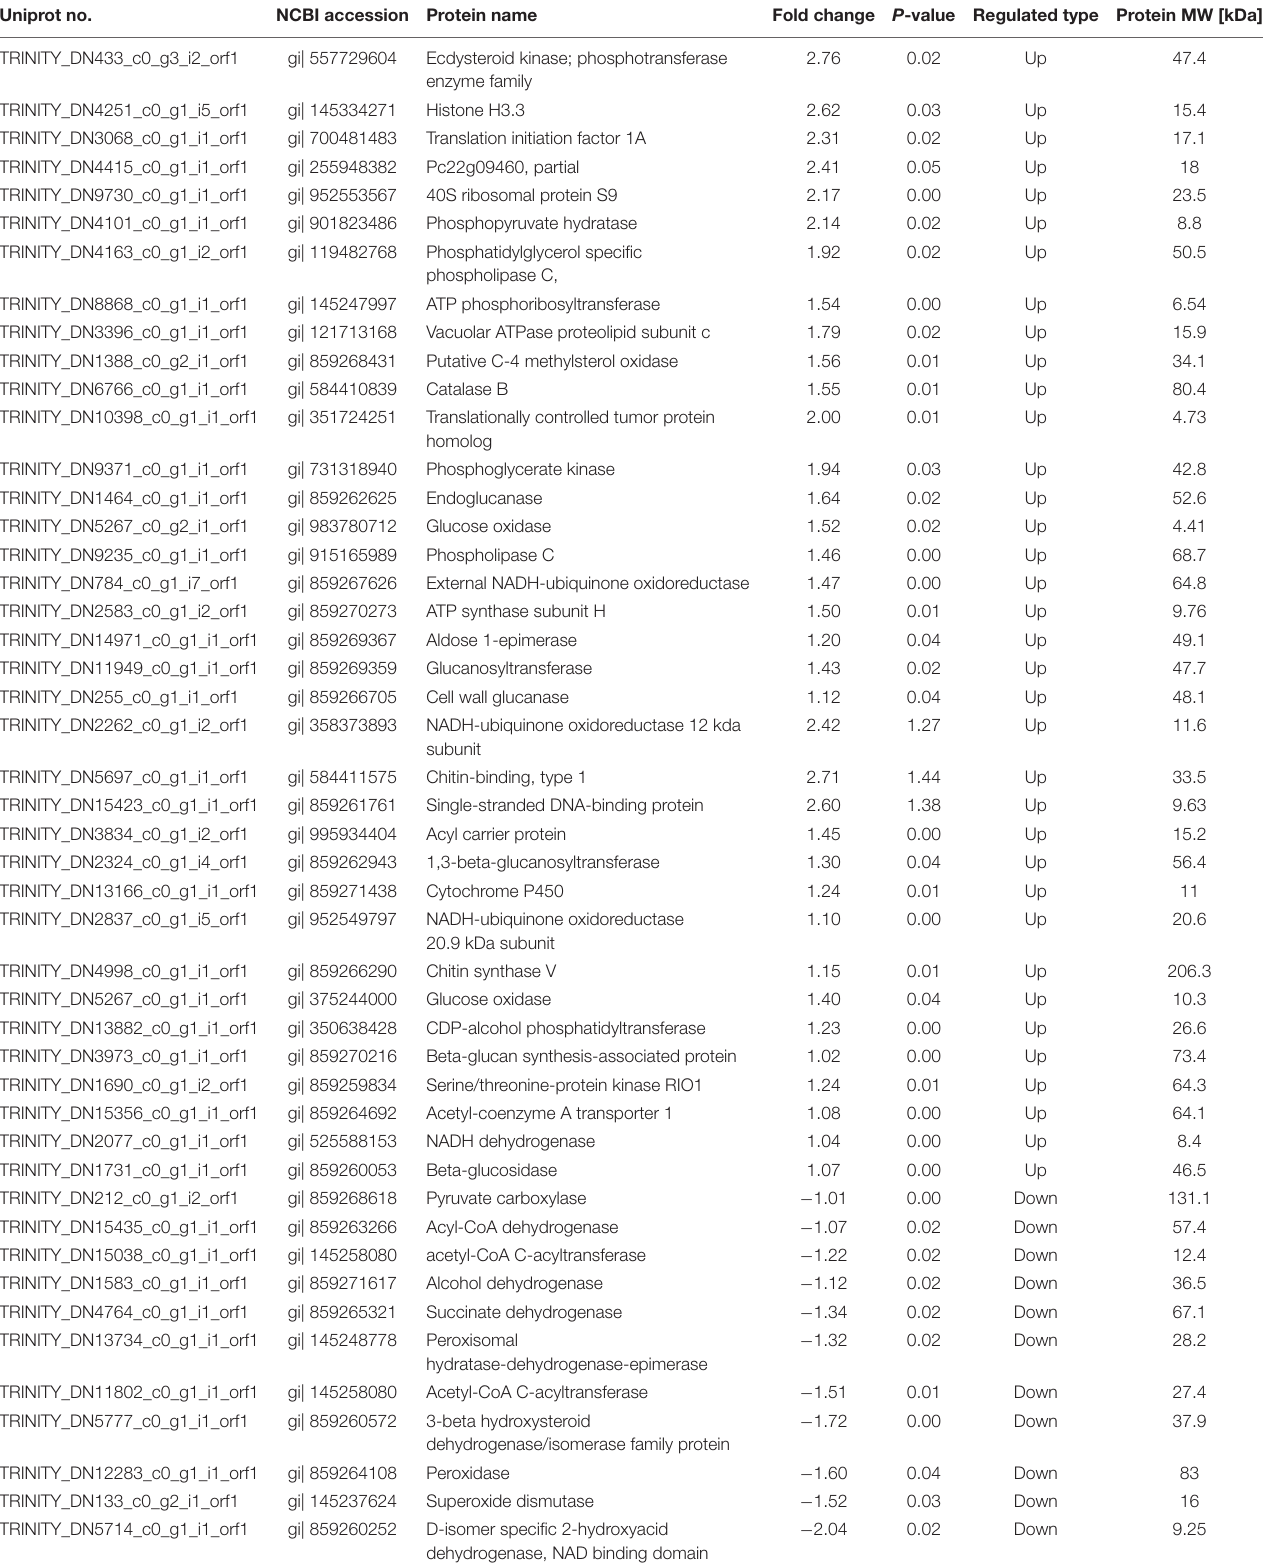
TABLE 1 | Identification of differentially expressed proteins in P. digitatum after X33 antifungal extract treatment. Uniprot no. NCBI accession Protein